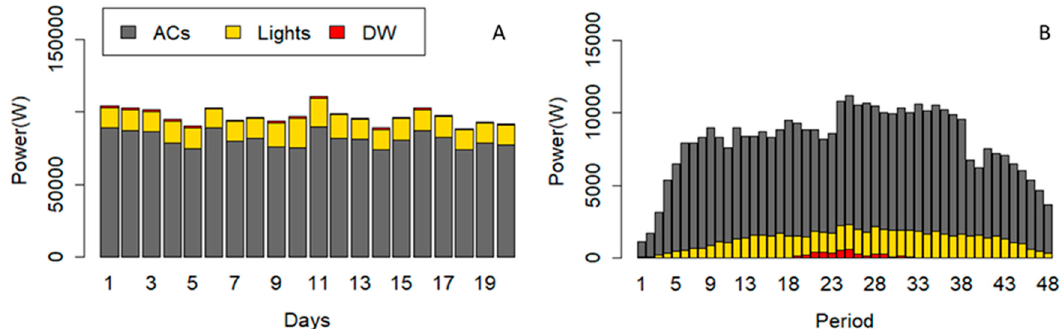
Figure 10. Power consumption of the devices after optimization in scenario A. ( A ) is correlated to